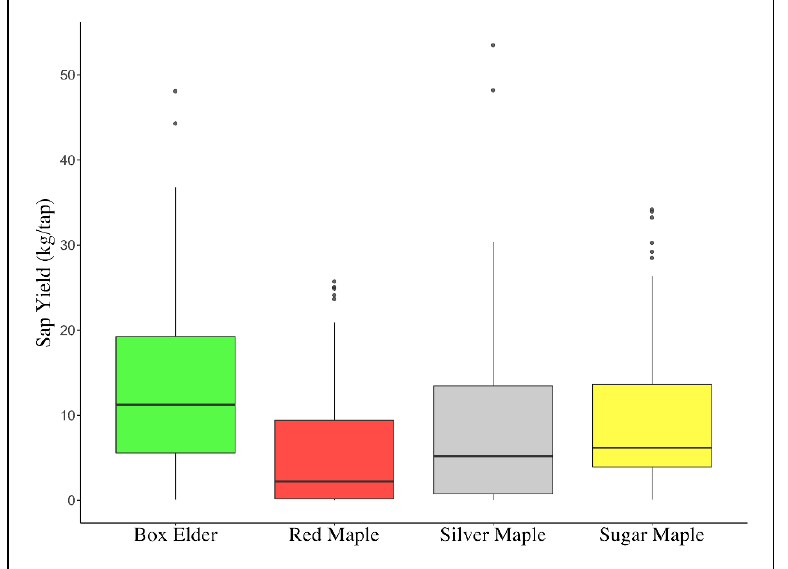
Figure 2. Seasonal Sap Yield Per Tap by Species The horizontal line bisecting each box represents median values, with 50% of data points falling within the box, and the upper and lower 25% of data points falling along the vertical lines above or below the box. Filled circles above boxes represent outliers that are more than two standard deviations from the